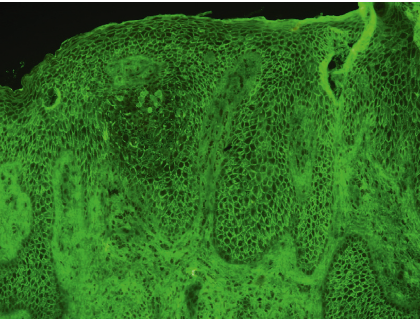
Figure 3: Direct immunofluorescence study showed positive IgG at the intercellular space of the